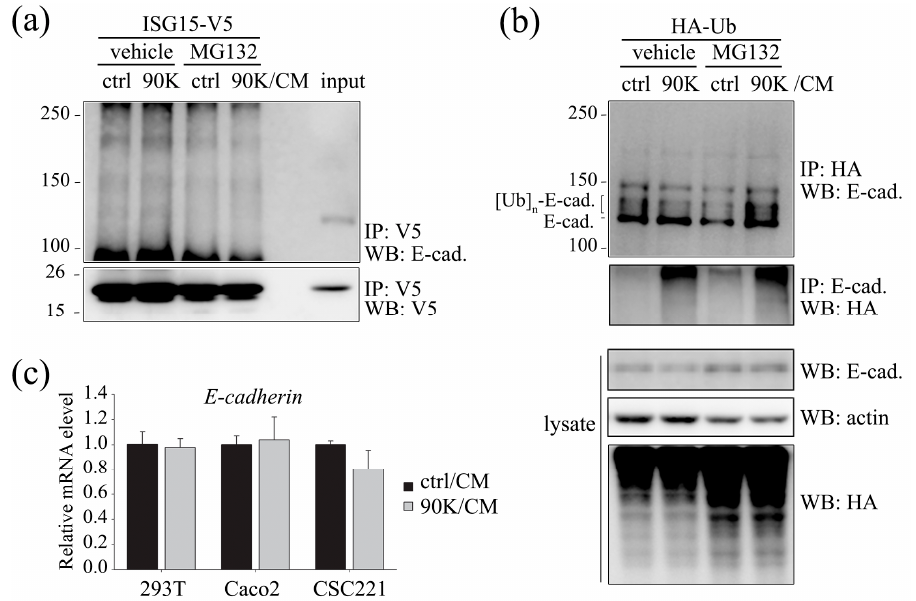
Figure 4. Regulation of E-cadherin level by 90K occurs via ubiquitination-mediated proteasomal degradation and not ISGylation. ( a ) 90K conditioned media (90K/CM) treatment did not induce ISGylation of E-cadherin. 293T cells were transfected with ISG15-V5, treated with either ctrl/CM or 90K/CM for 16 h, and immunoprecipitated with V5 antibody to pull down ISGylated proteins. Bound proteins were subjected to western blot analysis to detect ISG15-conjugated E-cadherin using an anti-E-cadherin antibody; ( b ) 90K/CM treatment promoted E-cadherin ubiquitination. 293T cells were transfected with HA-Ub, treated with either ctrl/CM or 90K/CM for 16 h, and immunoprecipitated with either anti-hemagglutinin (HA) or anti-E-cadherin antibody. Proteasome inhibitor, MG132, was used to block proteasomal degradation of ubiquitinated E-cadherin; ( c ) 90K/CM treatment did not affect E-cadherin mRNA levels. 293T cells were treated with either ctrl/CM or 90K/CM for 16 h, and E-cadherin mRNA level was analyzed by quantitative reverse transcription-polymerase chain reaction (RT-PCR).